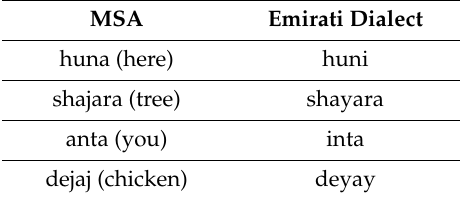
Table 1. Phonological and lexical di ff erences between MSA and Emirati